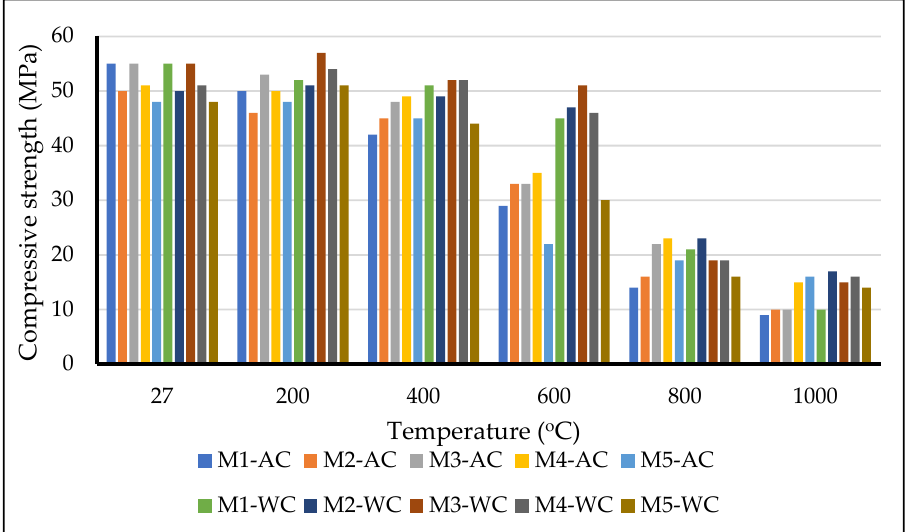
Figure 7. Mass loss of air-cured samples at elevated temperatures (where AC is air cooling, and WC is water cooling).